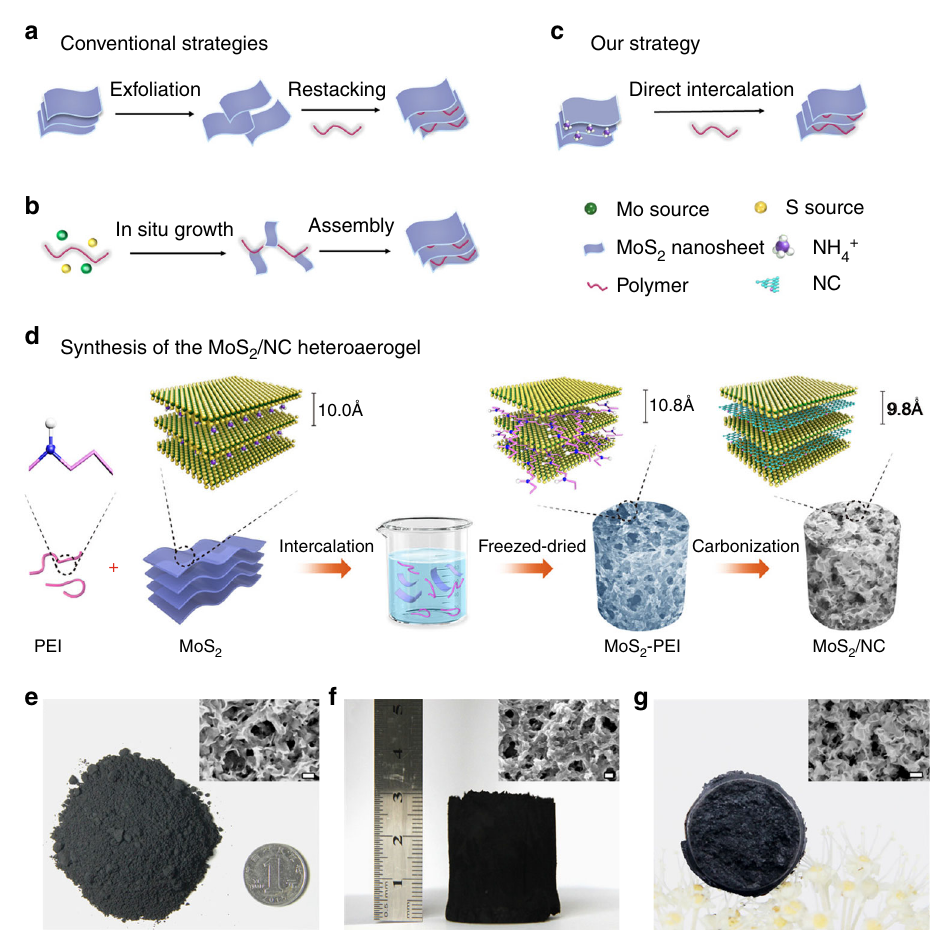
Fig. 1 Comparison of different strategies and the polymer direct intercalation. a – c The schematic illustrations show the conventional synthetic strategies to realize interlayer-expended MoS 2 ( a , b ) and the polymer-direct-intercalation (PDI) strategy for the synthesis of a MoS 2 /NC heteroaerogel ( c ) to prepare interlayer-expended MoS 2 /carbon composites. d The schematic illustration for the synthetic procedure of the MoS 2 /NC heteroaerogel. e – g Optical photographs of the as-synthesized pre-intercalated MoS 2 nanosheets ( e ), the MoS 2 -PEI (PEI, Mw = 600) composite after freeze-drying ( f ), and the MoS 2 / NC heteroaerogel after carbonization ( g ). Insets of ( e – g ) show the corresponding SEM images with scale bars of 100